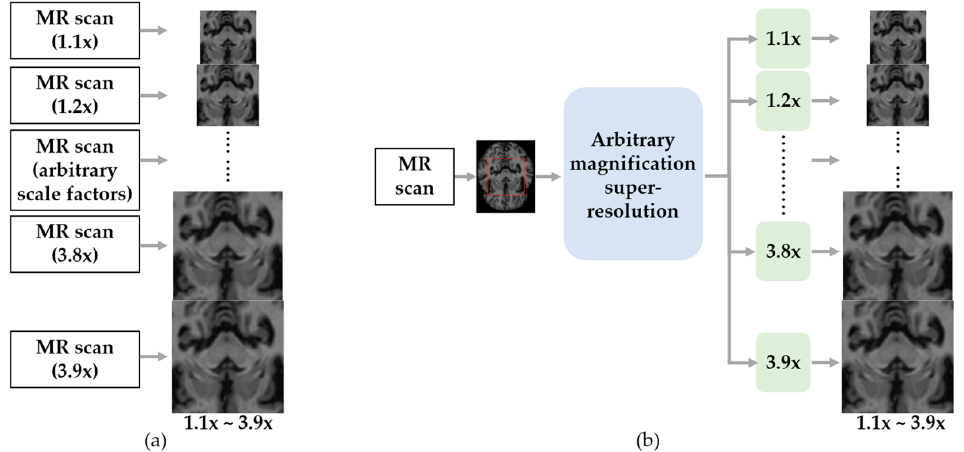
Figure 2. Example application of arbitrary magnification super-resolution in medical image pro- cessing task. ( a ) Conventional approach to obtain arbitrary magnification MR images. ( b ) Arbitrary magnification super-resolution approach to obtain arbitrary magnification MR images.